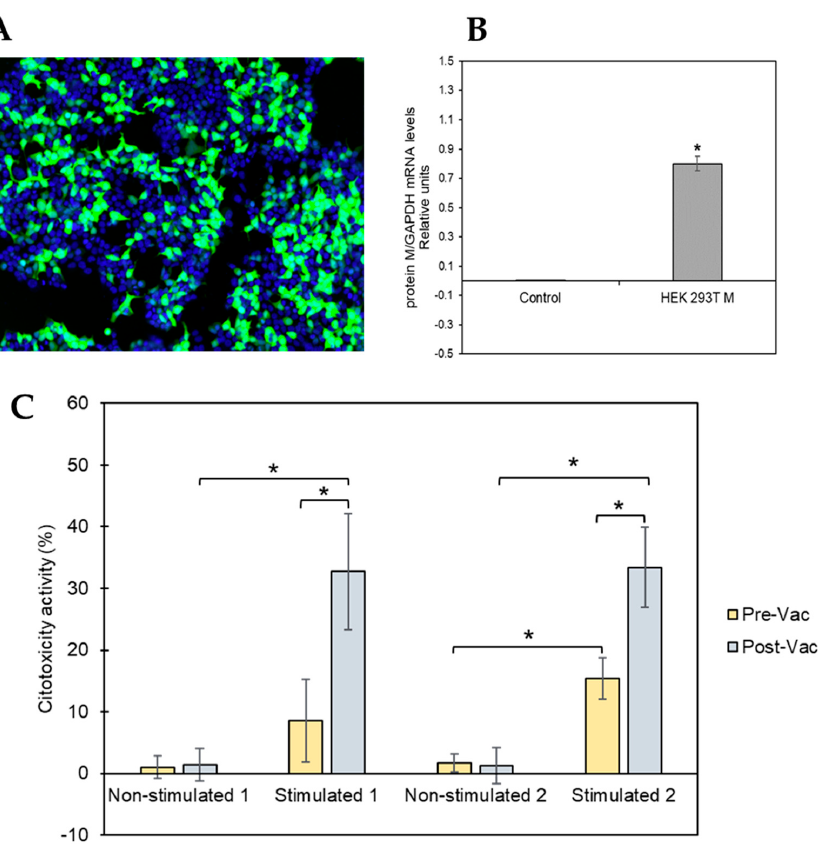
Figure 3. HEK 293Tcell model to test M-protein-mediated specific cytotoxicity activity. ( A ) Representative image of the transfected cells. Nuclei are shown in blue (Hoechst 33342), while transfected cells are visible in green (GFP). ( B ) Expression levels of SARS-CoV-2 mRNA for M protein were measured 48 h post-transfection of HEK 293T cells using RT-qPCR. The obtained results were normalized to the mRNA levels of the constitutive gene GAPDH. The asterisk (*) indicates that levels of SARS-CoV-2 mRNA for M protein were significantly higher ( p -value ≤ 0.05, tailed t-student test) in HEK 293T cells transfected with the plasmid pcDNATM3.1/myc-His containing the M protein coding gene than the levels obtained after transfecting the HEK 293T cells with the control plasmid (pcDNATM3.1). ( C ) Percentage of cytotoxic activity of the stimulated and non-stimulated T-cells against M protein of SARS-CoV-2 expressed in HEK 293Tcells in the membrane. T-cells isolated from two convalescent donors before and after vaccination were isolated for the cytotoxicity assay. All the experiments were performed at least in triplicate at both time points (before and after vaccination).